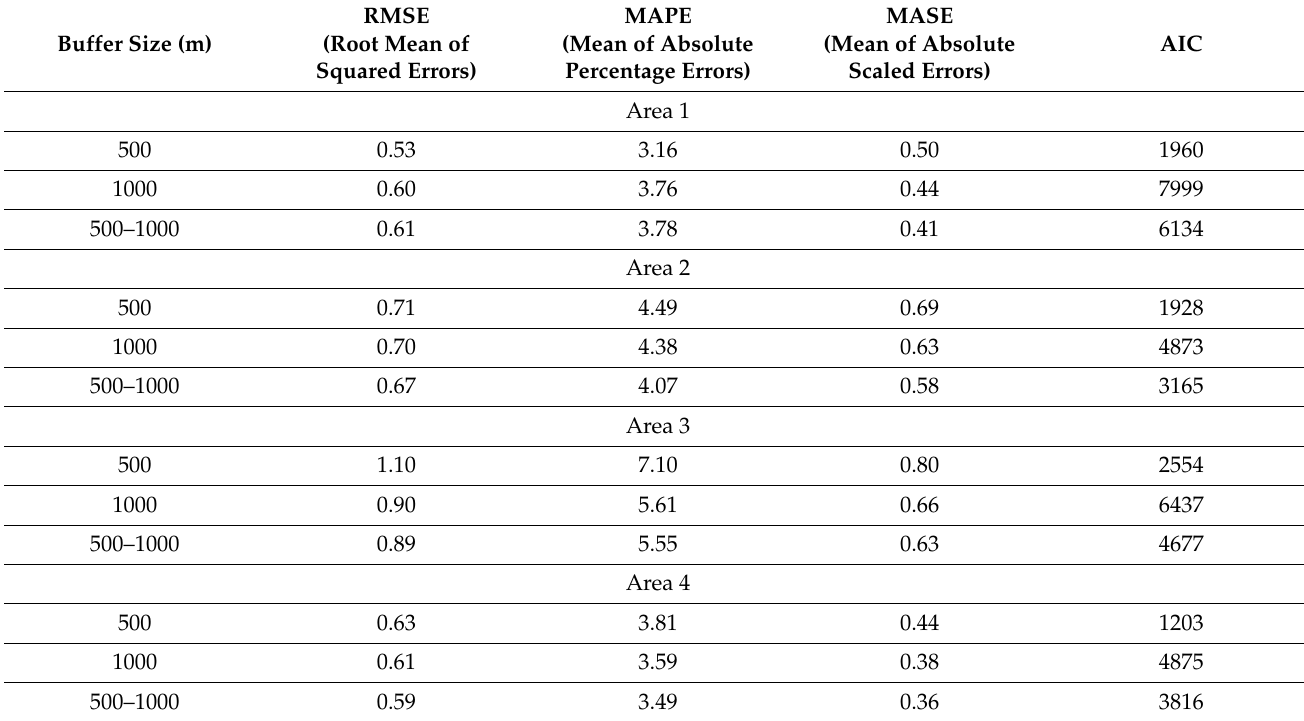
Table 3. Robustness of the